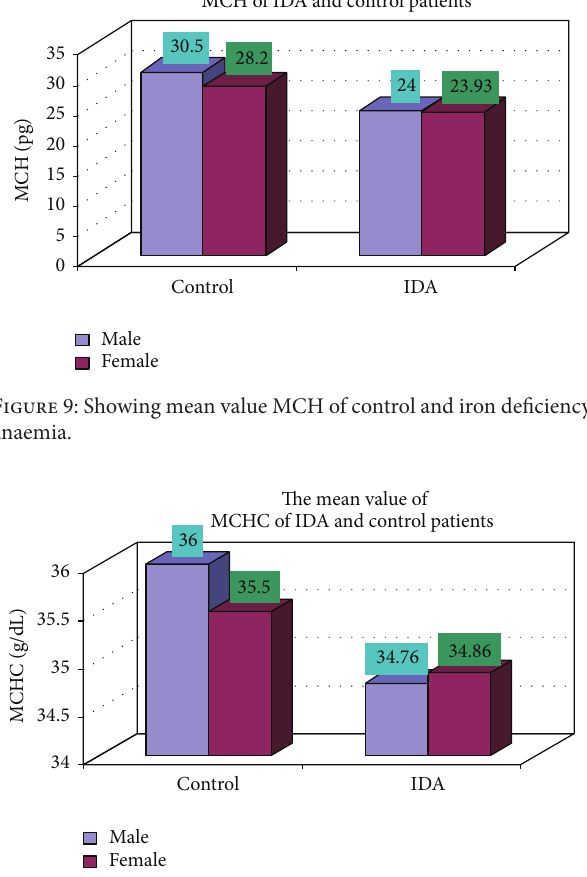
Figure 10: Showing the mean value MCHC of control and iron deficiency anemia.